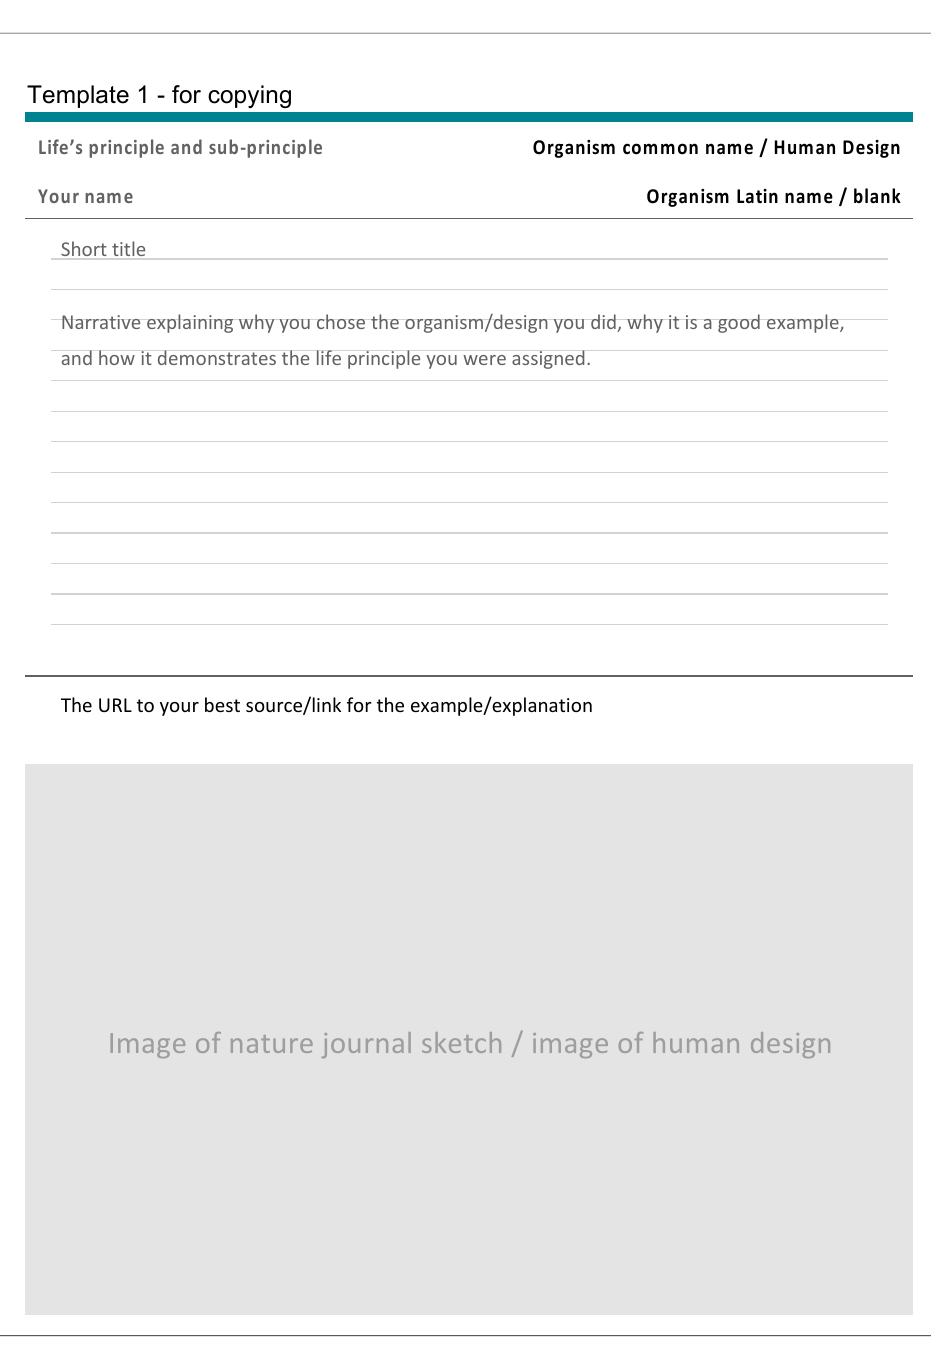
Figure 3. Exploring Life’s Principles in Nature and Design assignment template in google slides.